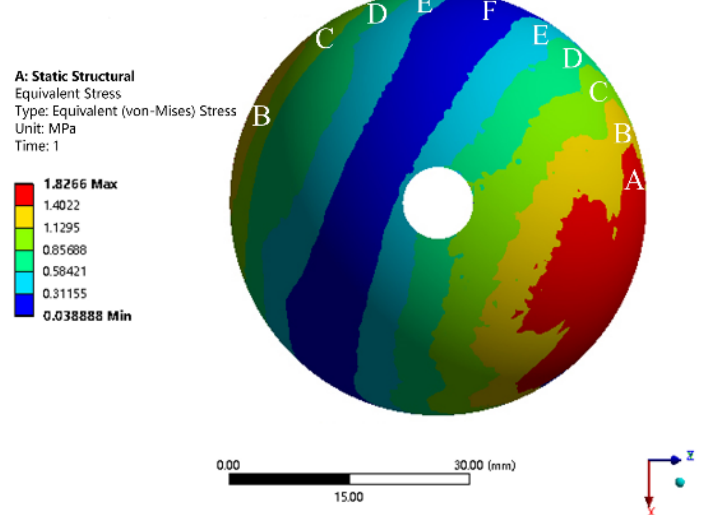
Figure 11. Superimposition of stress map at each transient.